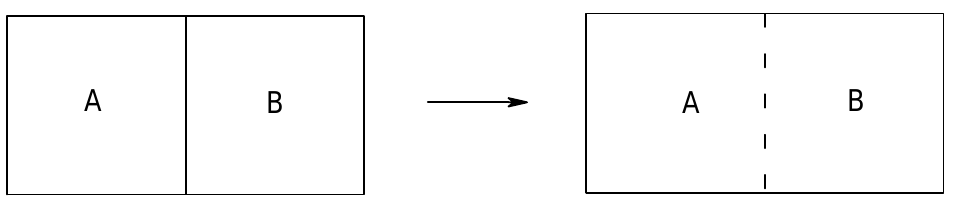
Figure 5. Mass (ideal gas) transfer and heat transfer between two parts of a chamber after removal of the barrier. The whole system is an isolated